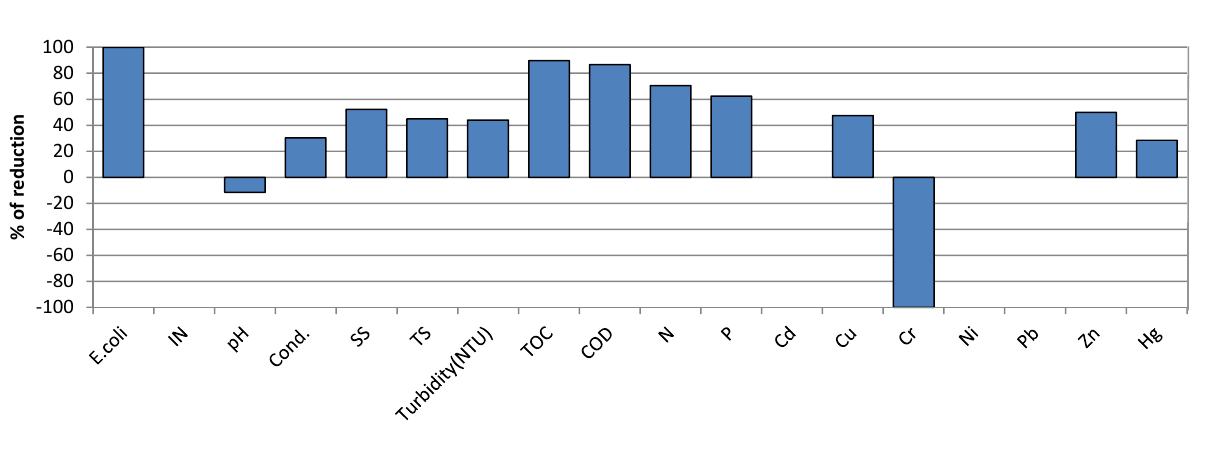
Figure 13. Pollutant reduction of filter trench (self-made from results obtained by Llopart-Mascaró et al.